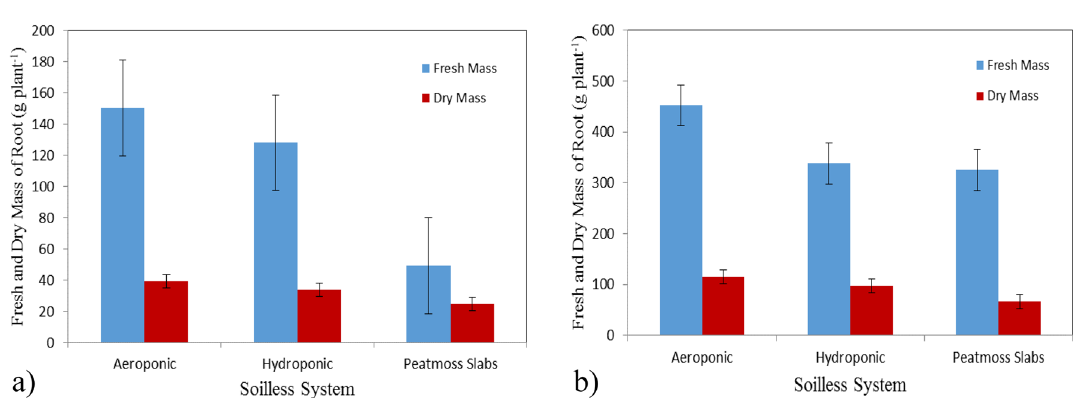
Figure 6. Fresh and dry mass of root of basil plants, ( a ) at vegetative stage and ( b ) at flowering